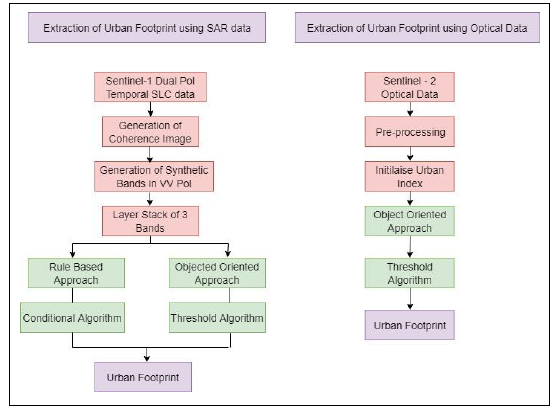
Figure 5: Methodology Flowchart of second objective